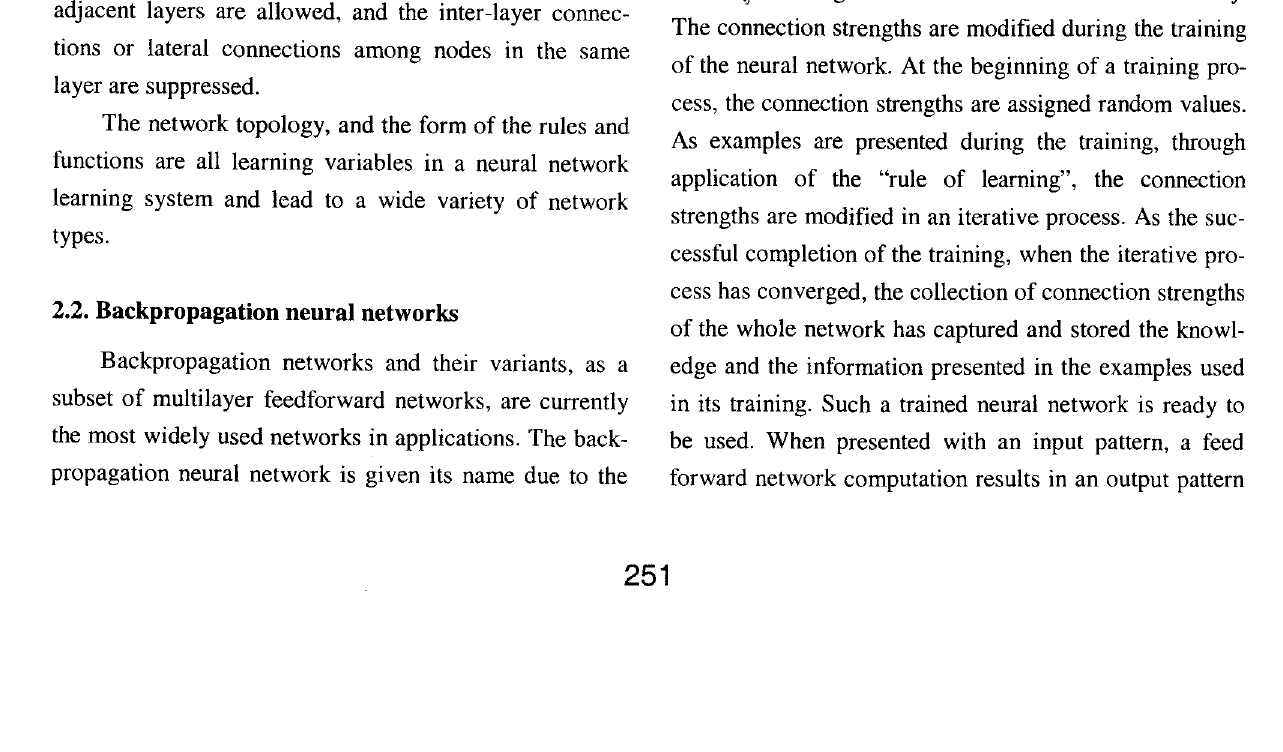
Fig 1. An example of backpropagation neural network Associated with each connection is a numerical value which is the strength or the weight of that connec tion: wiJ = strength of connection between units i and